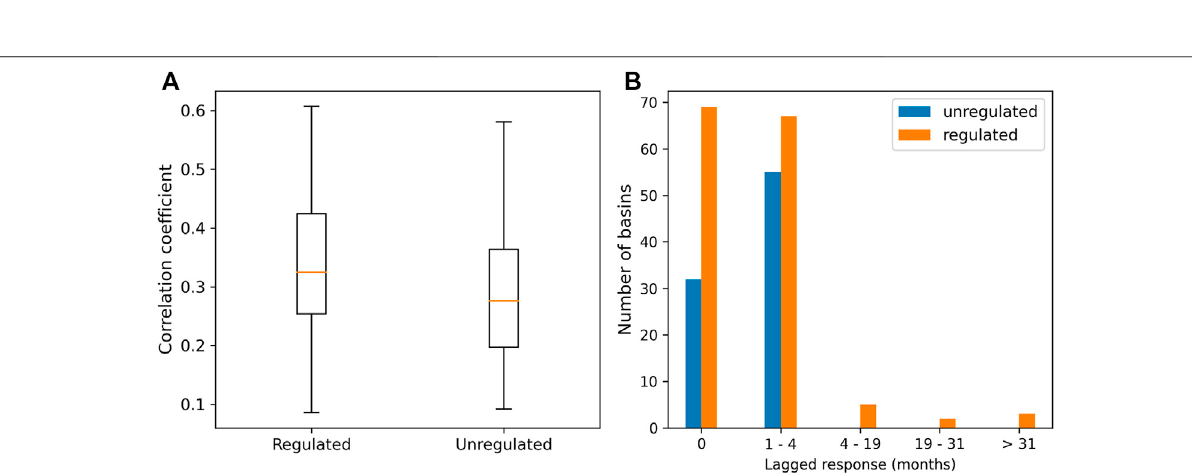
Frontiers in Environmental Science |